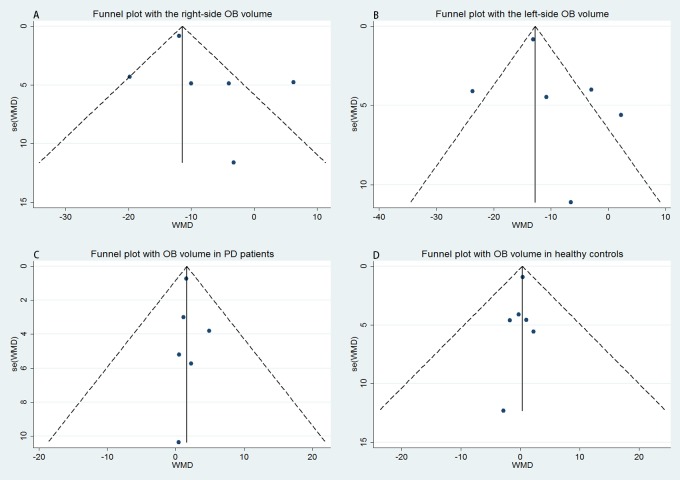
Funnel plots of the relationship between the size of the effect of individual studies and the precision of the study estimate (WMD, horizontal axis; s.e., vertical axis) for the right OB volume (A), the left OB volume (B), and the OB volume in PD patients (C) and in healthy controls (D). WMD = weighted mean difference.